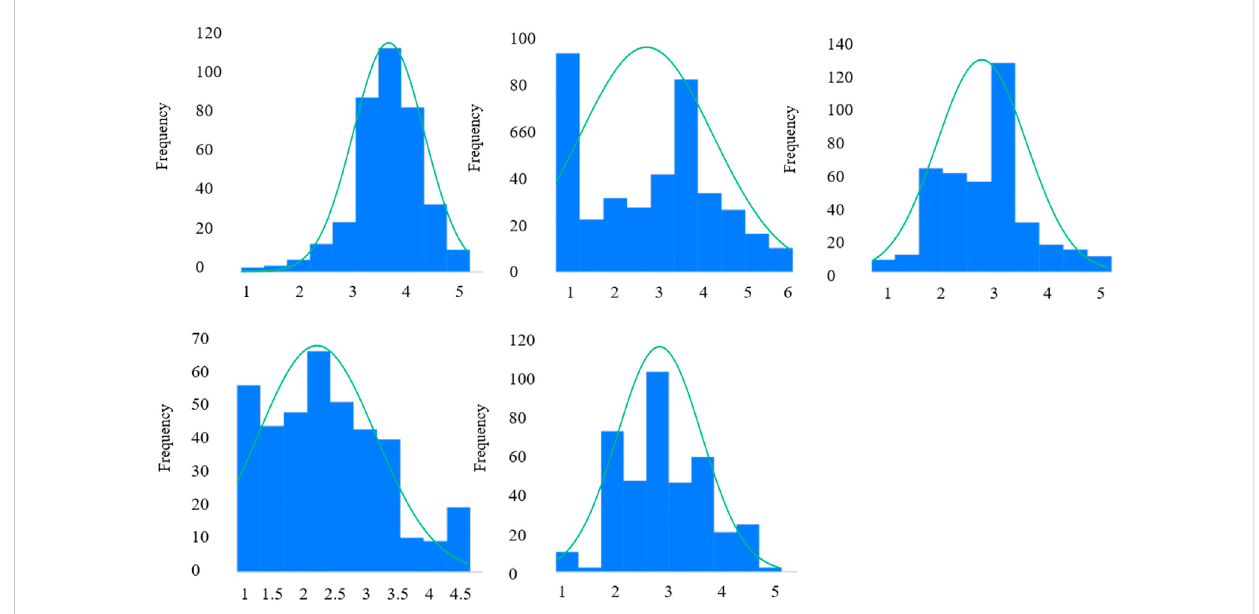
FIGURE 2 Normality test histogram for different age groups.